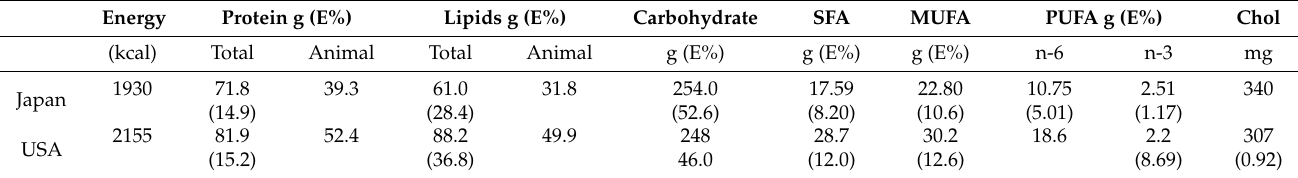
Table 1. Comparison of daily nutrient intake between Japanese and the US